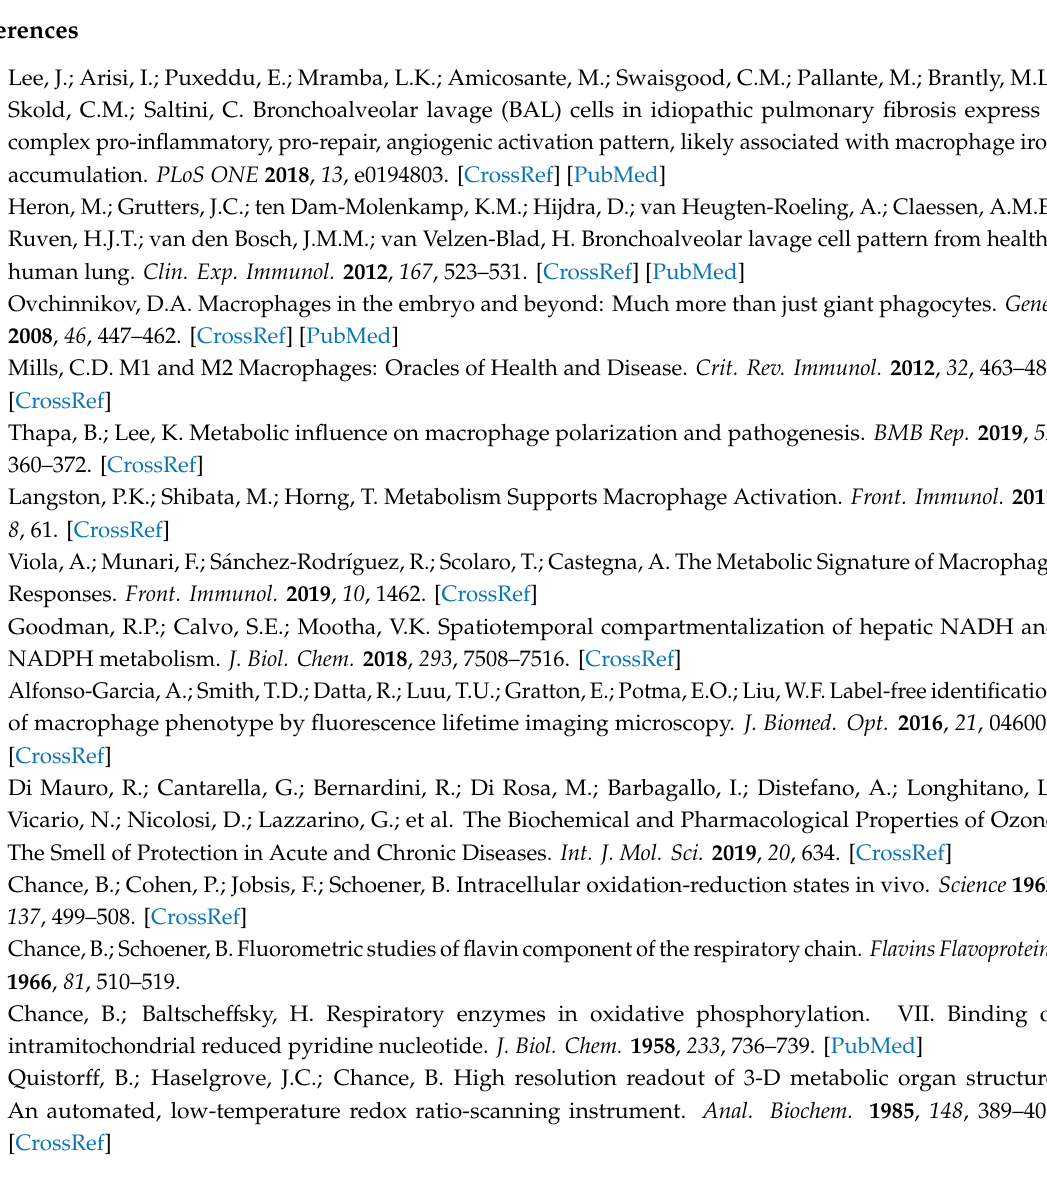
Figure S1: ORI-detected AM redox heterogeneity within a male KO mouse with prior ozone exposure shows a bimodal redox state. Table S1: The mean redox indices of the studied mice exposed to filtered air (FA, as control group) or Ozone (O 3